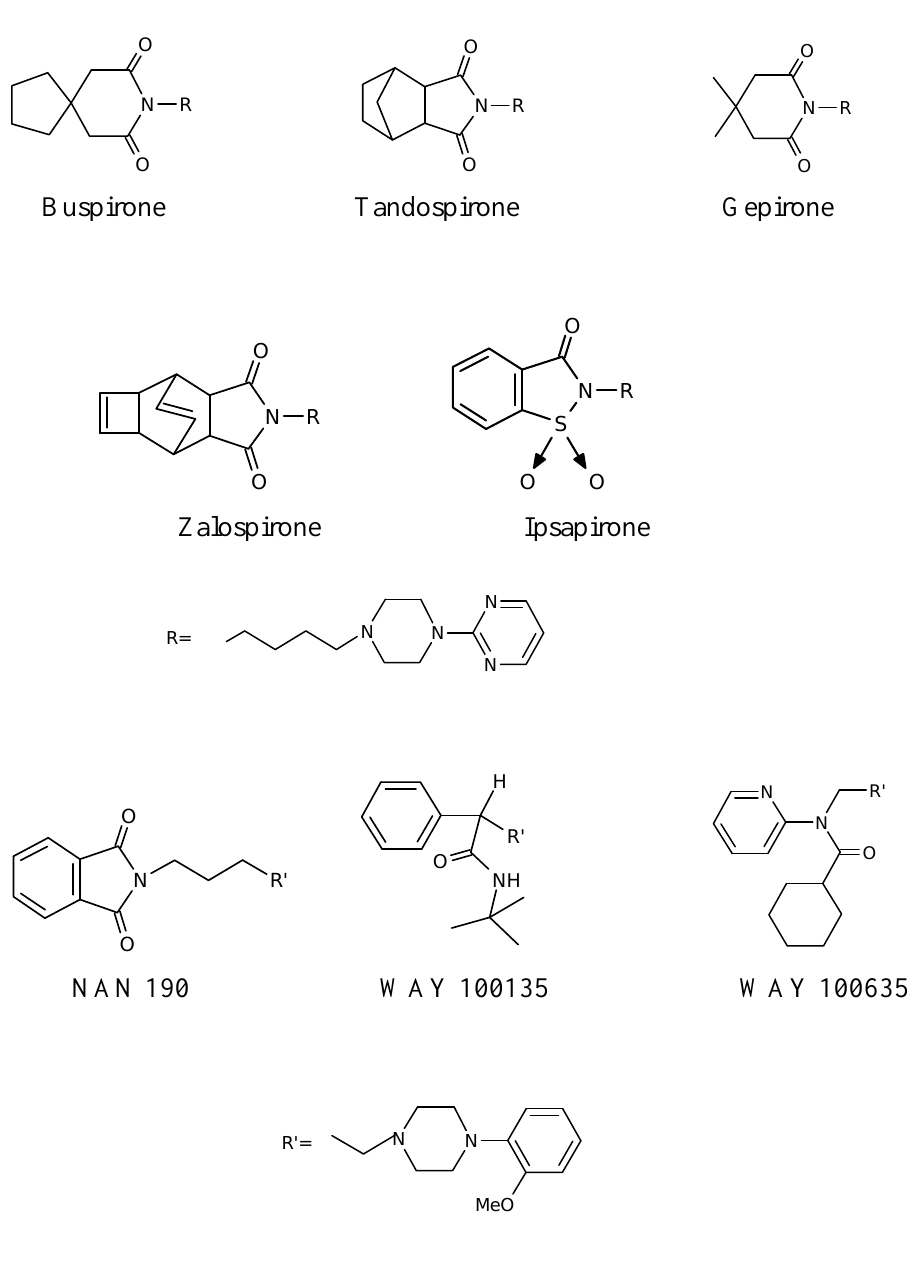
Figure 1. LCAPs with an amide and imide